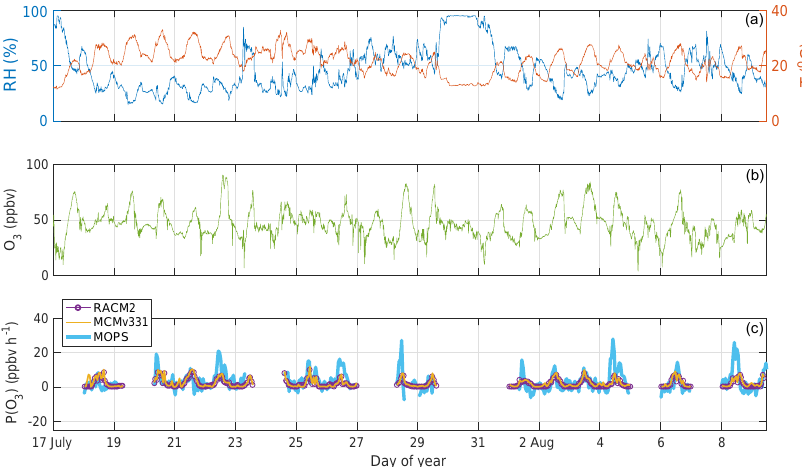
Figure 1. (a) Full-campaign 10min temperature and relative humidity in Golden, CO. The “warm” period is defined as days before 27 July 2014. (b) Full-campaign 10min O 3 mixing ratios for 17 July to 10 August 2014. (c) P(O 3 ) measured by the MOPS and mod- eled by RACM2 and MCMv331 for the same time period. Measured to modeled comparisons are shown for days with available MOPS measurements and are averaged over a 1h time period.